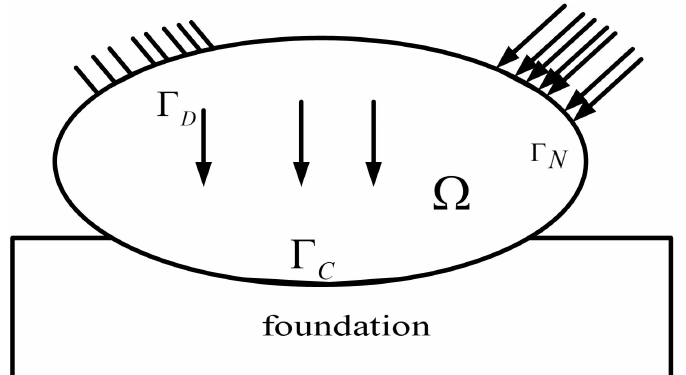
Figure 6. A deformable body in contact with a